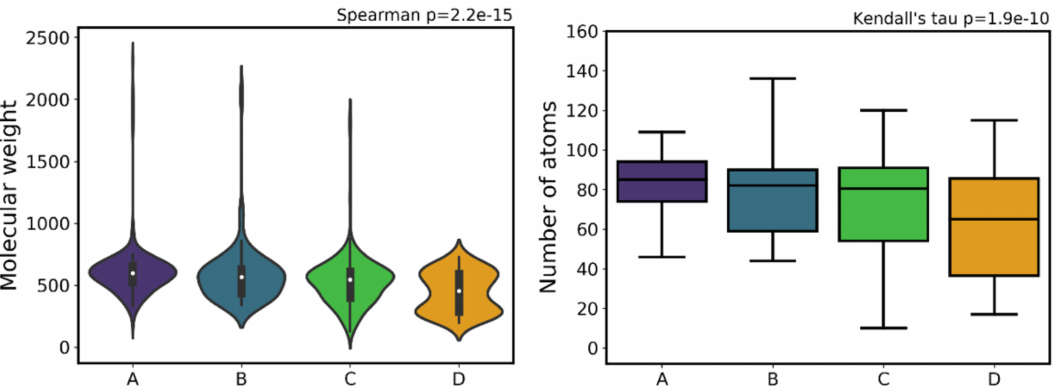
Figure 9. Distribution of Molecular Weight (MW) (left) and number of atoms (a_count) (right) across the di ff erent activity